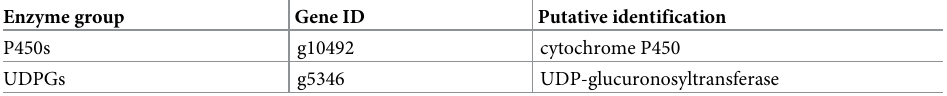
Given are up-regulated differentially expressed genes (DEGs) with a putative function in detoxification. Detailed information can be found in the S6